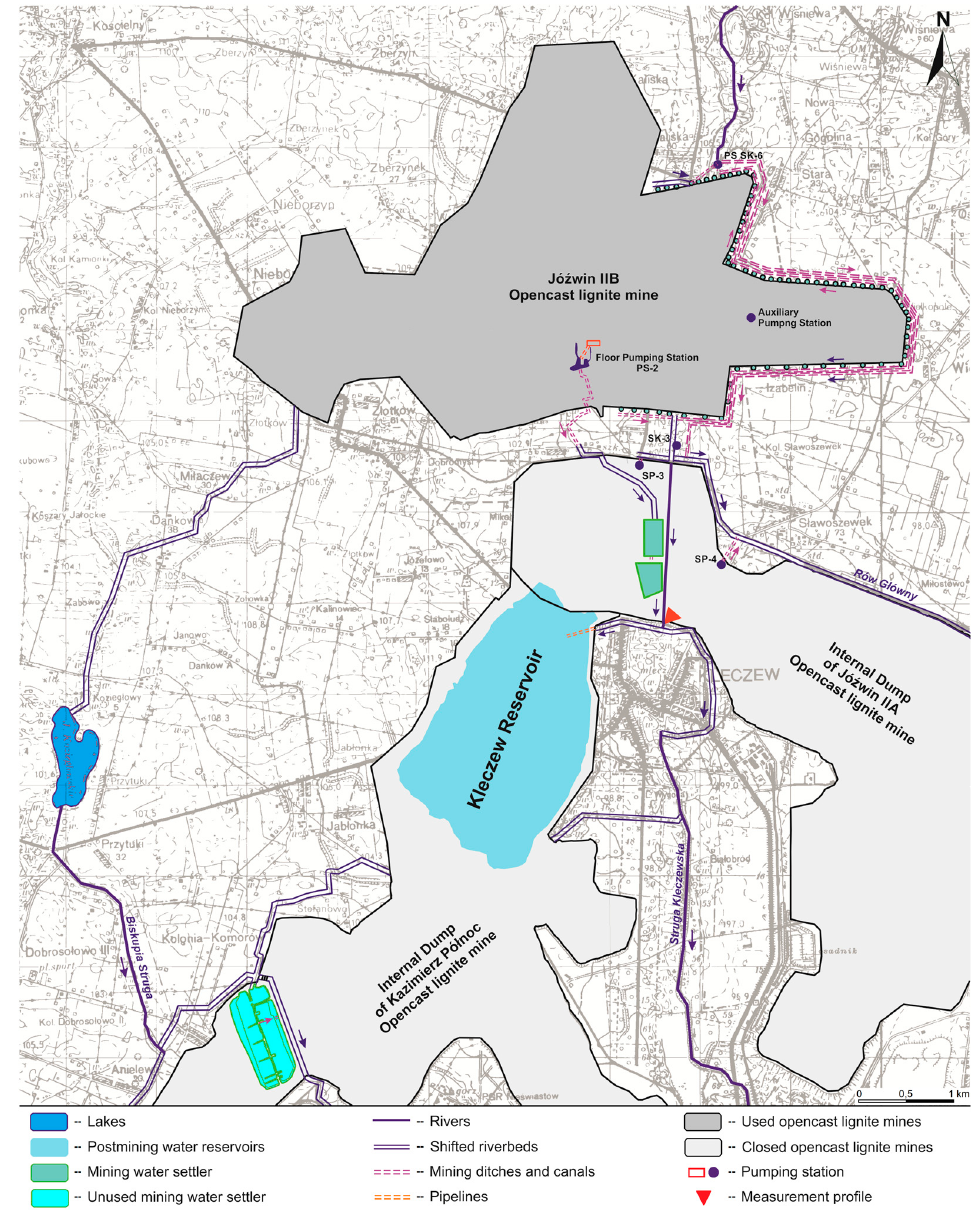
Figure 3. Diagram of drainage of opencast lignite mine Jó ź win IIB and supply to the former opencast mine Kazimierz Pó ł noc.